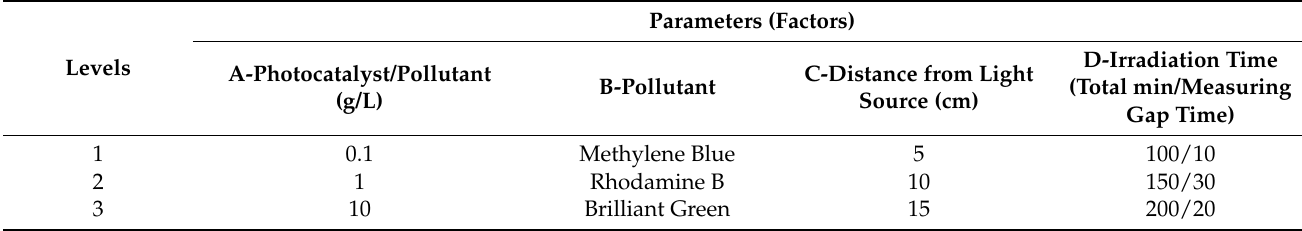
Table 1. Taguchi orthogonal array L9 factors and their levels.